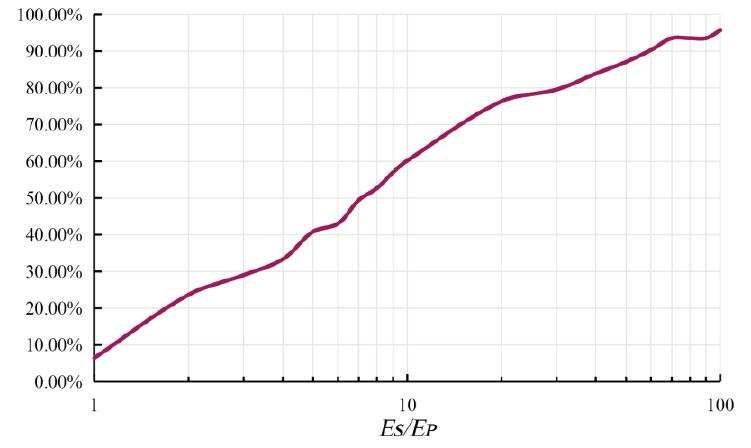
Figure 8. Percentage distribution of E S / E P values (20 October 2020 to 10 November 2020).